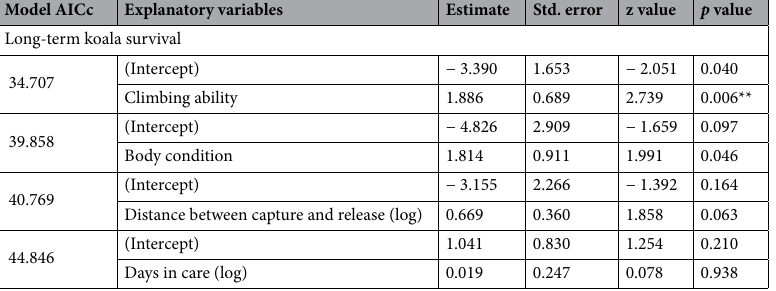
Table 4. Summary output for models examining climbing ability, body score, distance between capture and release sites, and days in care against long-term survival. Significant relationships are identified by asterisks, near significant (0.075 > p > 0.05) relationships identified by dots.